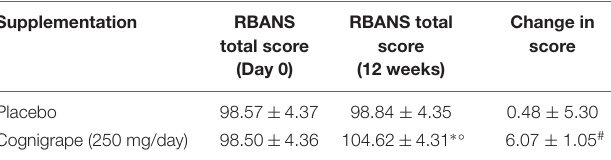
TABLE 3 | Effects of Cognigrape or placebo supplementation for 12 weeks on Repeatable Battery for the Assessment of Neuropsychological Status (RBANS) total score in healthy older subjects.